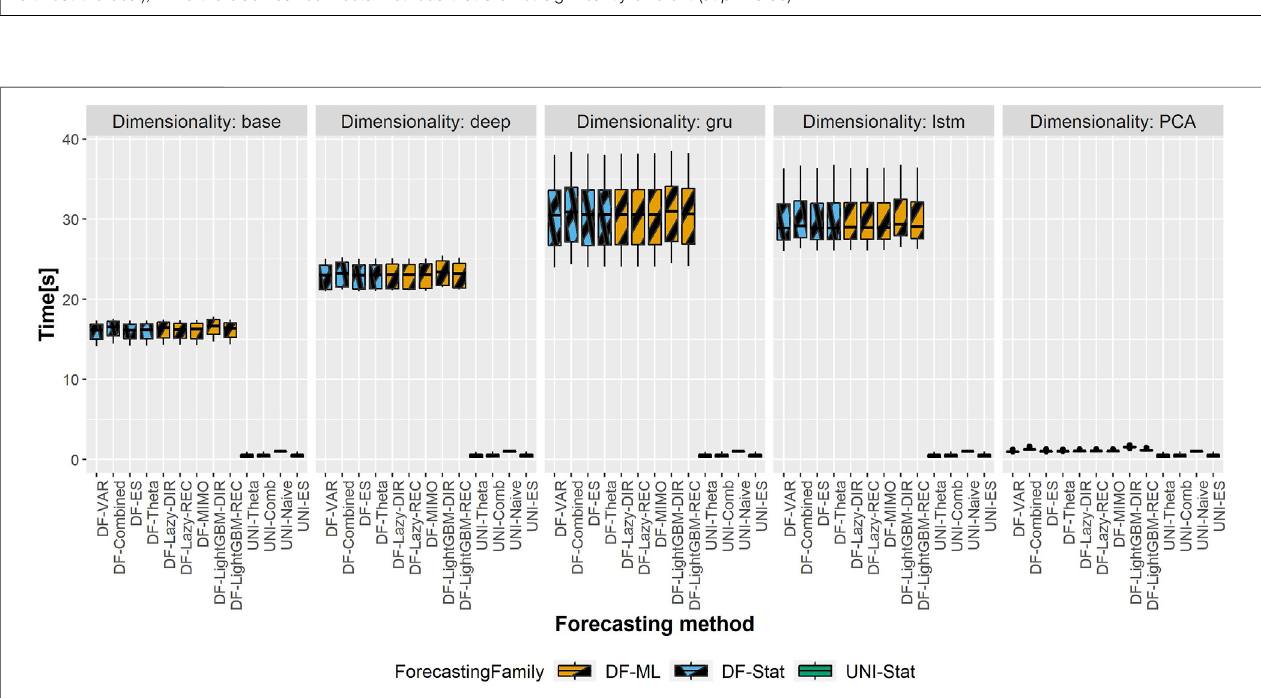
FIGURE6| Traf fi c — Boxplotsrepresentingthedistributionofthecomputationaltime(ins)acrossthedifferentrollingwindowsfortheshortesthorizon( H (cid:1) 4).Each column in the grid represents a different factor estimation technique.